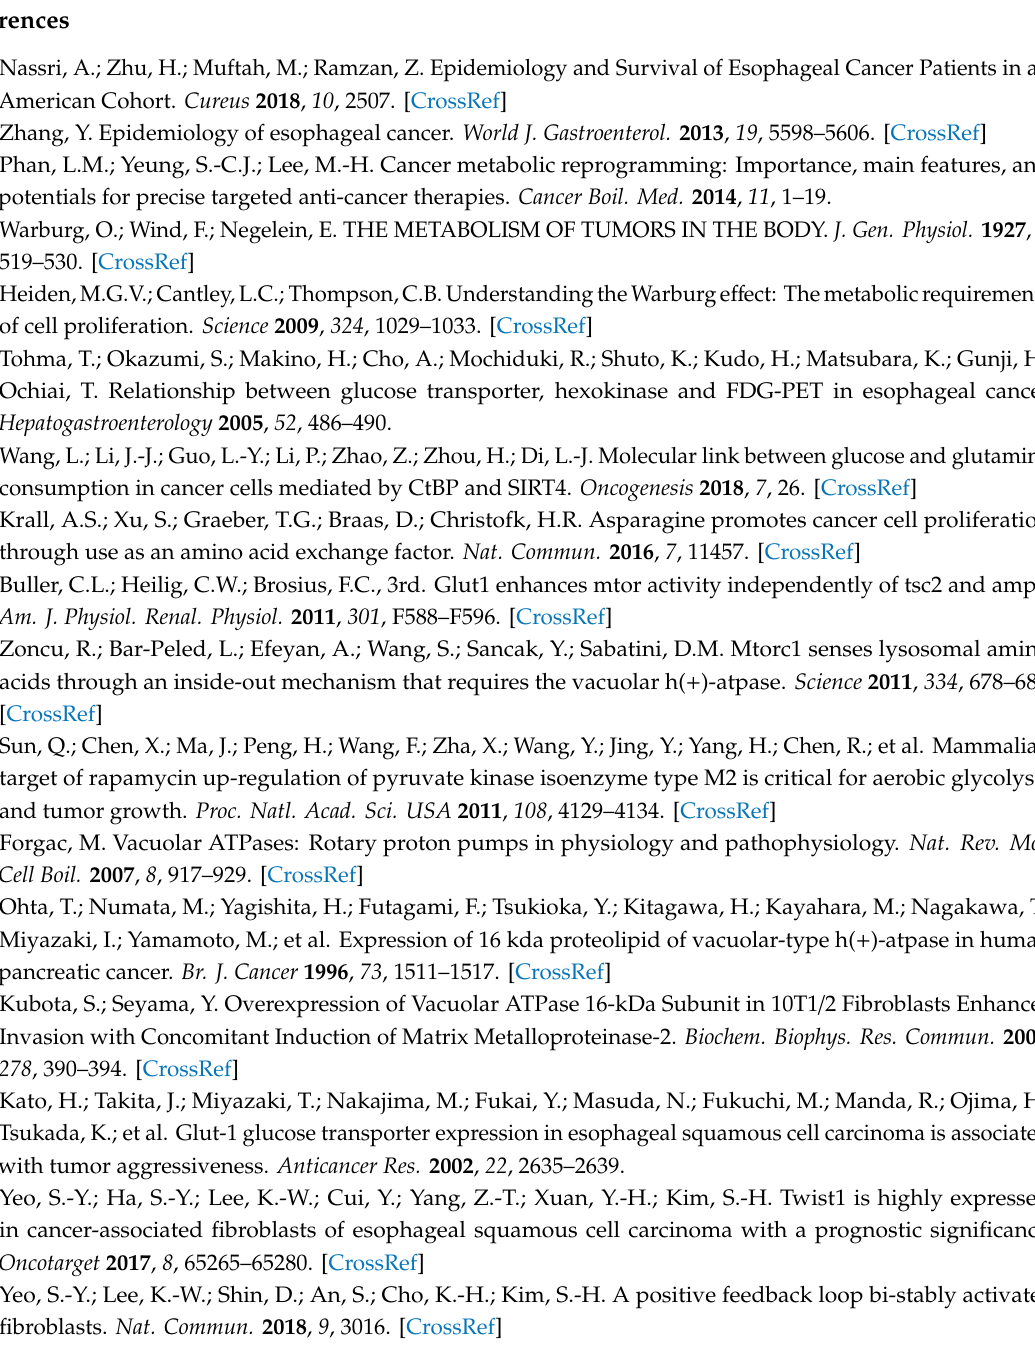
esophageal normal fibroblasts (ENFs). Figure S3: ATP6V0C depletion attenuates proliferation of various cancer cell lines. Figure S4: The sub-cellular localization of ATP6V0C in TE8 cells. Table S1: Primers used for quantitative RT-